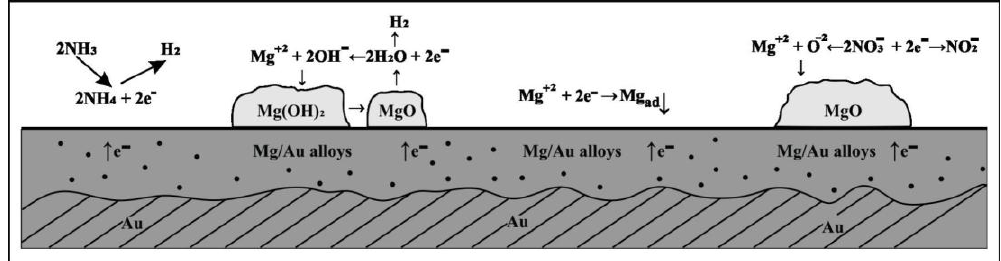
Figure 6. Schematic representation of the processes taking place on the surface of Au cathode during magnesium underpotential deposition and Mg/Au alloys formation in the melts made of nonaqueous eutectic [Mg(NO 3 ) + NH 4 NO 3 ] mixture and of eutectic [Mg(NO 3 ) · 6H 2 O + NH 4 NO 3 · XH 2 O] mixture.